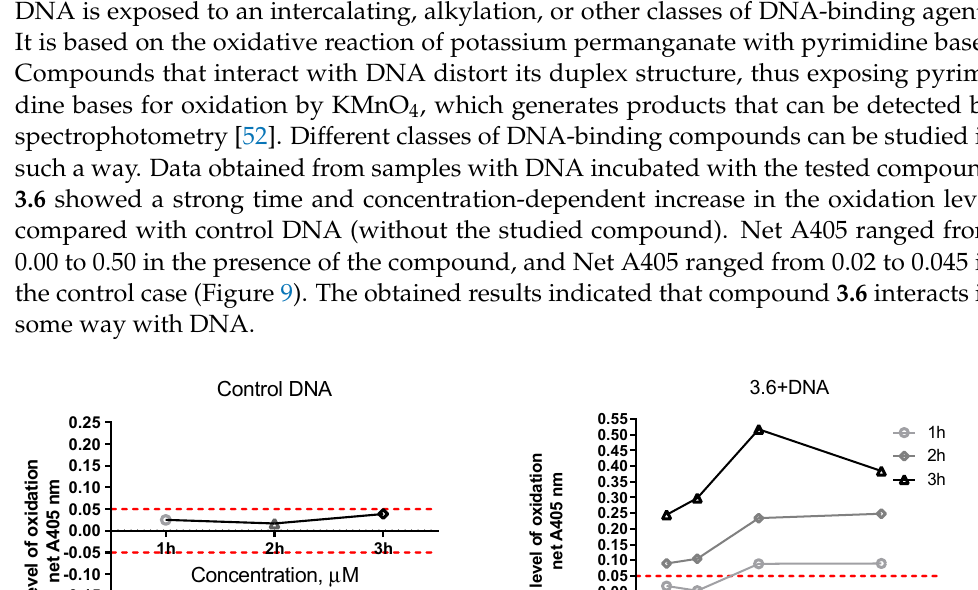
Figure 8. DNA ladder in KB3-1 cells following 24 h exposure to the compound 3.6 and doxorubicin (Dox, 1 µ М ).